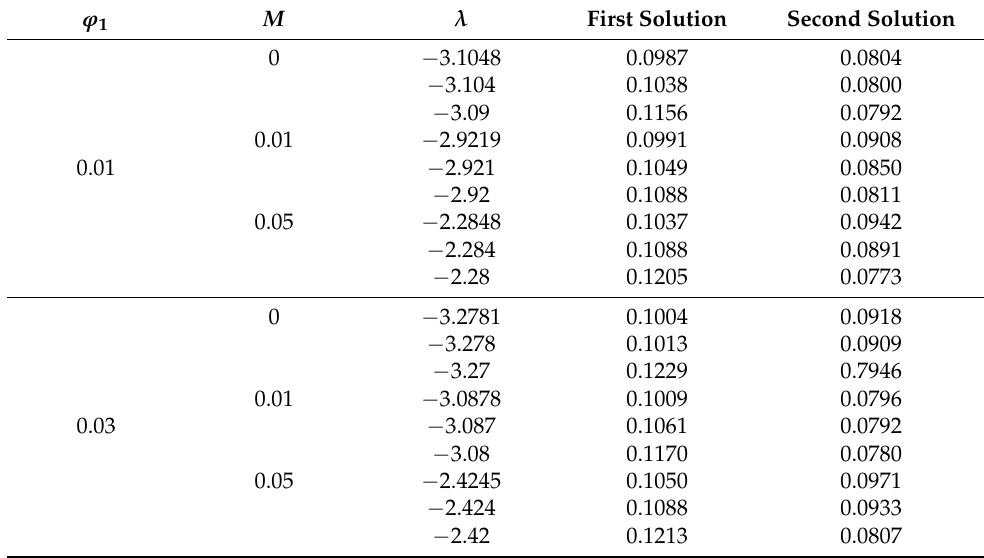
Table 4. Least eigenvalues γ for selected ϕ 2 with several values of M when ϕ 2 = 0.01, ε = c = 0.1.